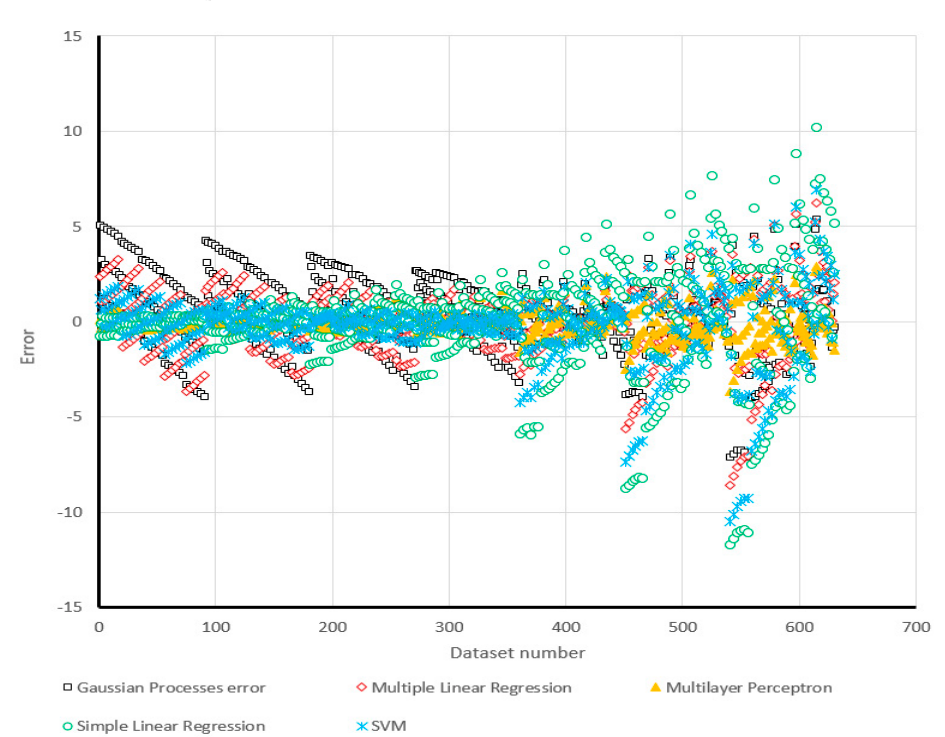
Figure 7. Comparison of the errors obtained from the proposed models.